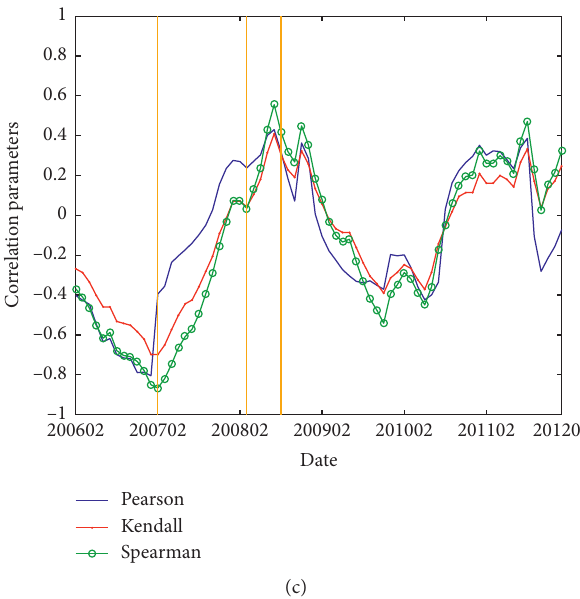
Figure 7: Yield spreads, liquidity risk, and the correlation parameters during financial